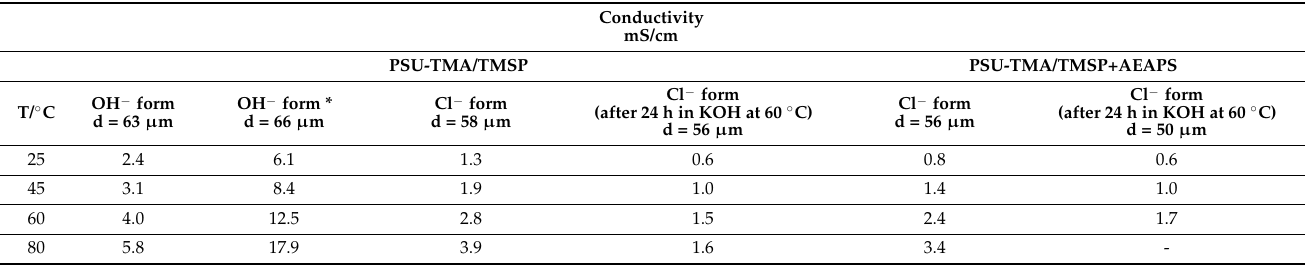
Table 2. Ionic conductivity of